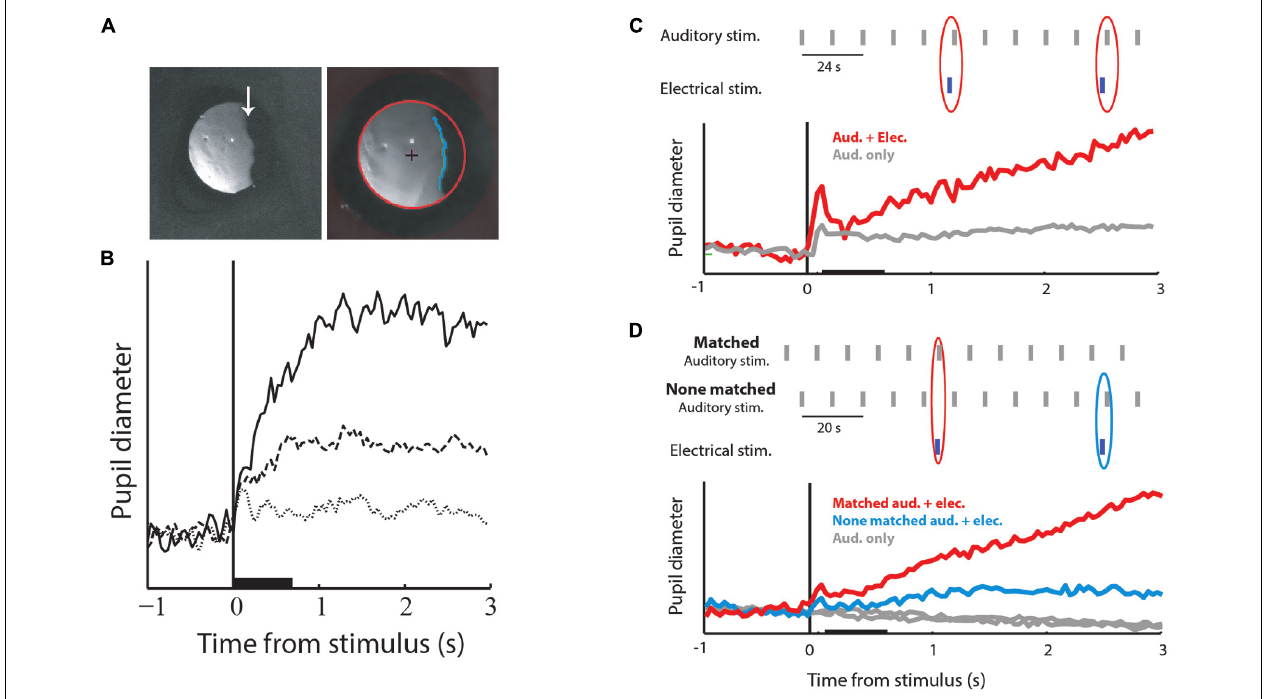
the stimulation protocol. Auditory stimuli were repeated every 12 s (gray bars). Occasionally, with a probability of 20%, a brief low-level microstimulation was injected shortly before the auditory stimulus (blue bars). The gray curve shows the population average PDR to the repeated auditory stimulus.The red curve shows the population average PDR to the auditory stimuli that followed a microstimulation. Note the release from habituation. (D) The inset shows the time course of the experiment.The gray vertical bars indicate auditory stimuli and the blue vertical bars electrical stimulations. Auditory stimuli were repeated every 10 s alternating between two positions: one matching the electrical stimulation site in the tectal map and the other not matching the electrical stimulation site.The gray curves show the population PDRs to the two auditory stimuli.The blue curve shows the population PDR to the non-matched auditory stimuli that were coupled with the microstimulation, and the red curve the population PDR to the matched auditory stimuli coupled with the microstimulation. Microstimulation at the site corresponding with the acoustic stimulus induces a stronger release from habituation. Modified from Netser etal.